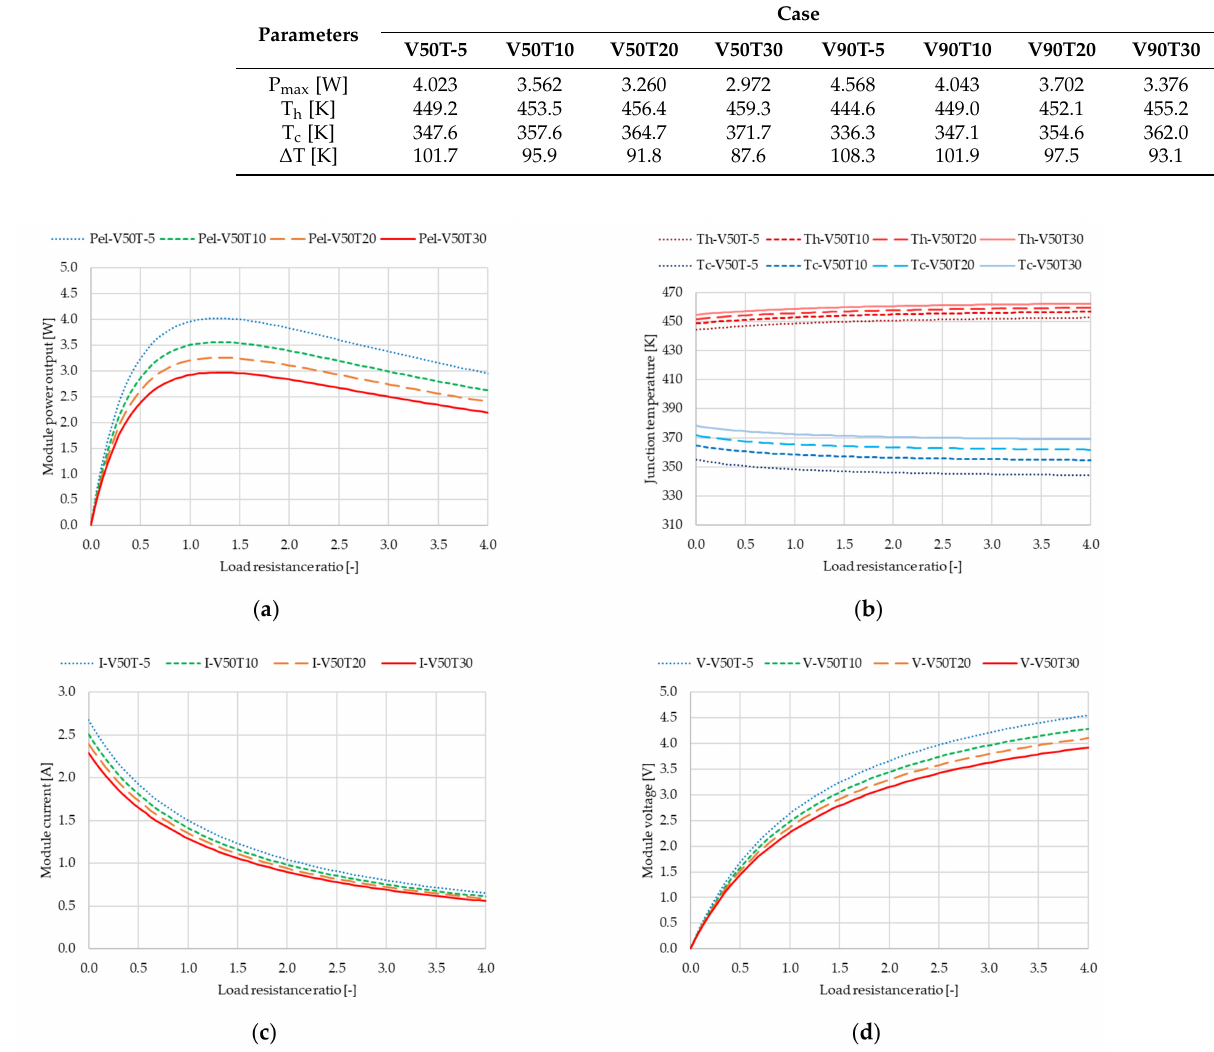
Figure 15. ( a ) Module power output, ( b ) junction temperature, ( c ) module current, and ( d ) module voltage with respect to the load resistance ratio for a velocity of 50 km/h at various temperatures ( − 5, 10, 20, and 30 ◦